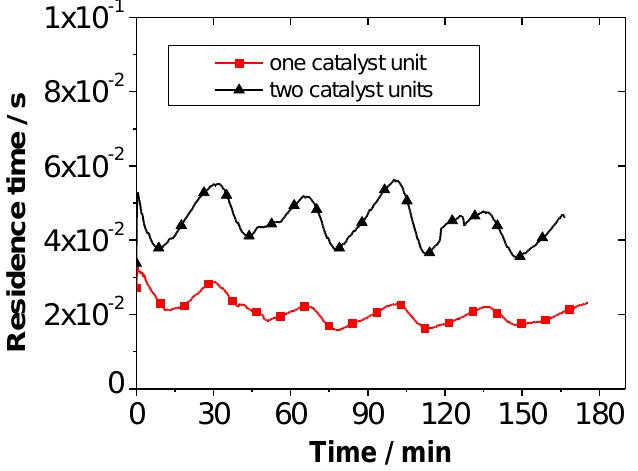
Figure 5. Residence time of the flue gas in the catalyst during operation with one and two catalyst units. (The values are not dependent on the different materials